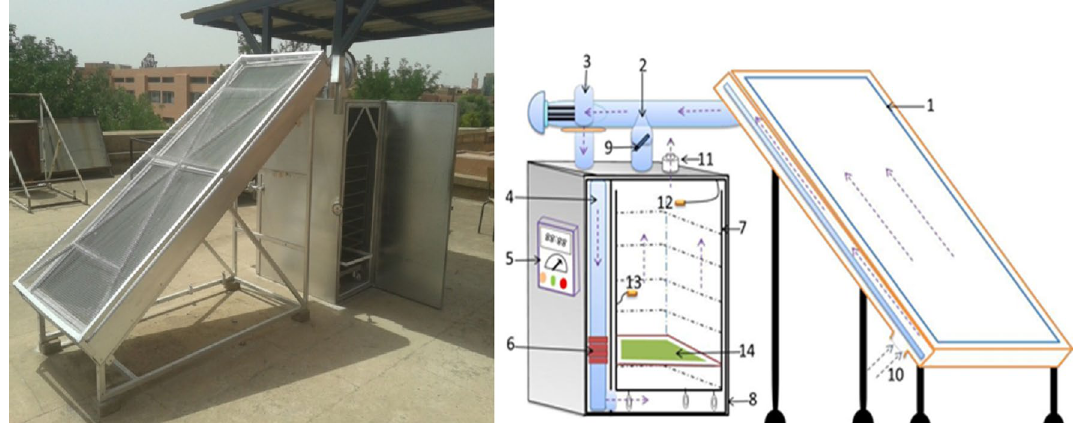
Figure 1. Schematic diagram of the solar dryer. (1) Solar collector, (2) circulation fan, (3) fan, (4) air flow direction, (5) control box, (6) auxiliary heating system, (7) shelves, (8) drying cabinet, (9) recycling air, (10) control foot, (11) exit of air, (12) humidity probes and (13) thermocouples (14) sample holder (Ouaabou et al. 19